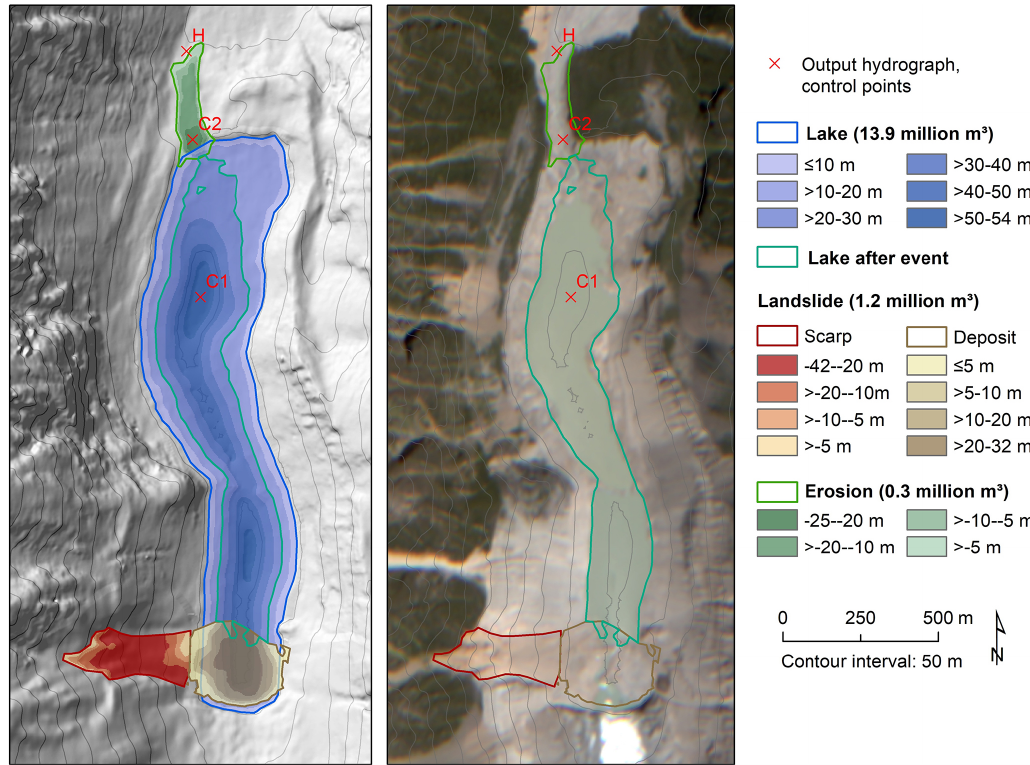
Figure 5. Reconstruction of the lake depth, landslide, and breach of the moraine dam. The base map is a shaded relief map (left) based on the DEM generated from Ziyuan-3 stereoscopic pairs and the Ziyuan-3 satellite scene (right) acquired on 25 August